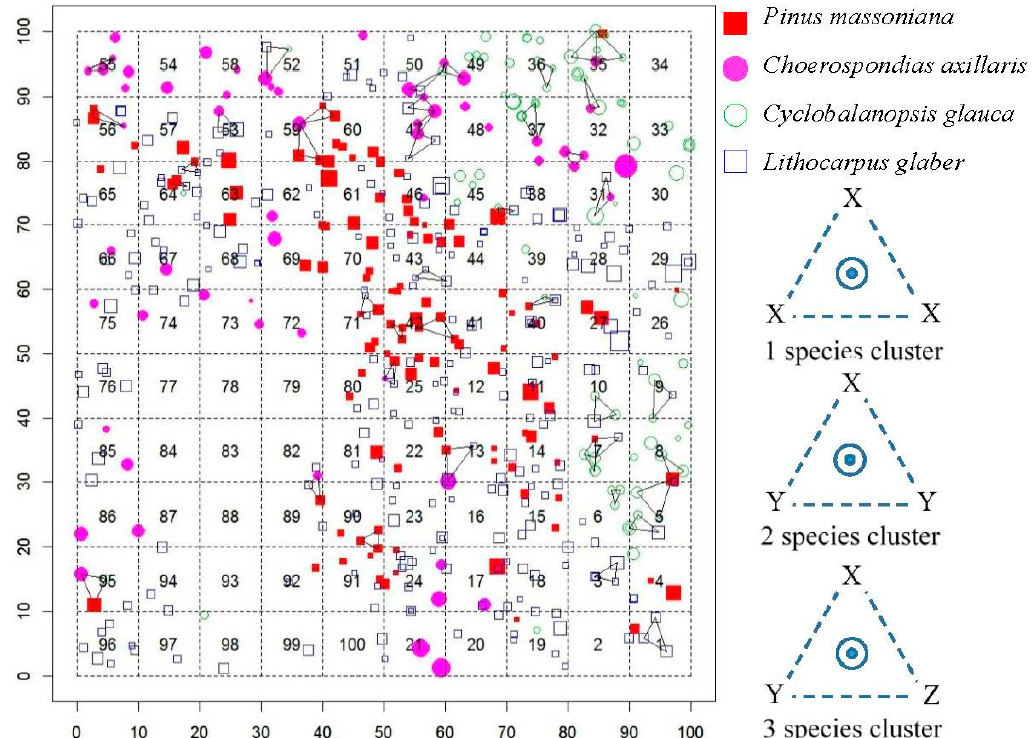
Figure 1. Experimental design and layout of tree clusters in gradient of tree species richness, ranging from one to two and three tree species combinations in L. glaber - C. glauca forest. X, Y and Z represent the different species of P. massoniana, C. axillaris, C. glauca or L . glaber. The central filled circle represents the soil sampling point. The size of the colorful symbol represents the DBH size, DBH > 10 cm.